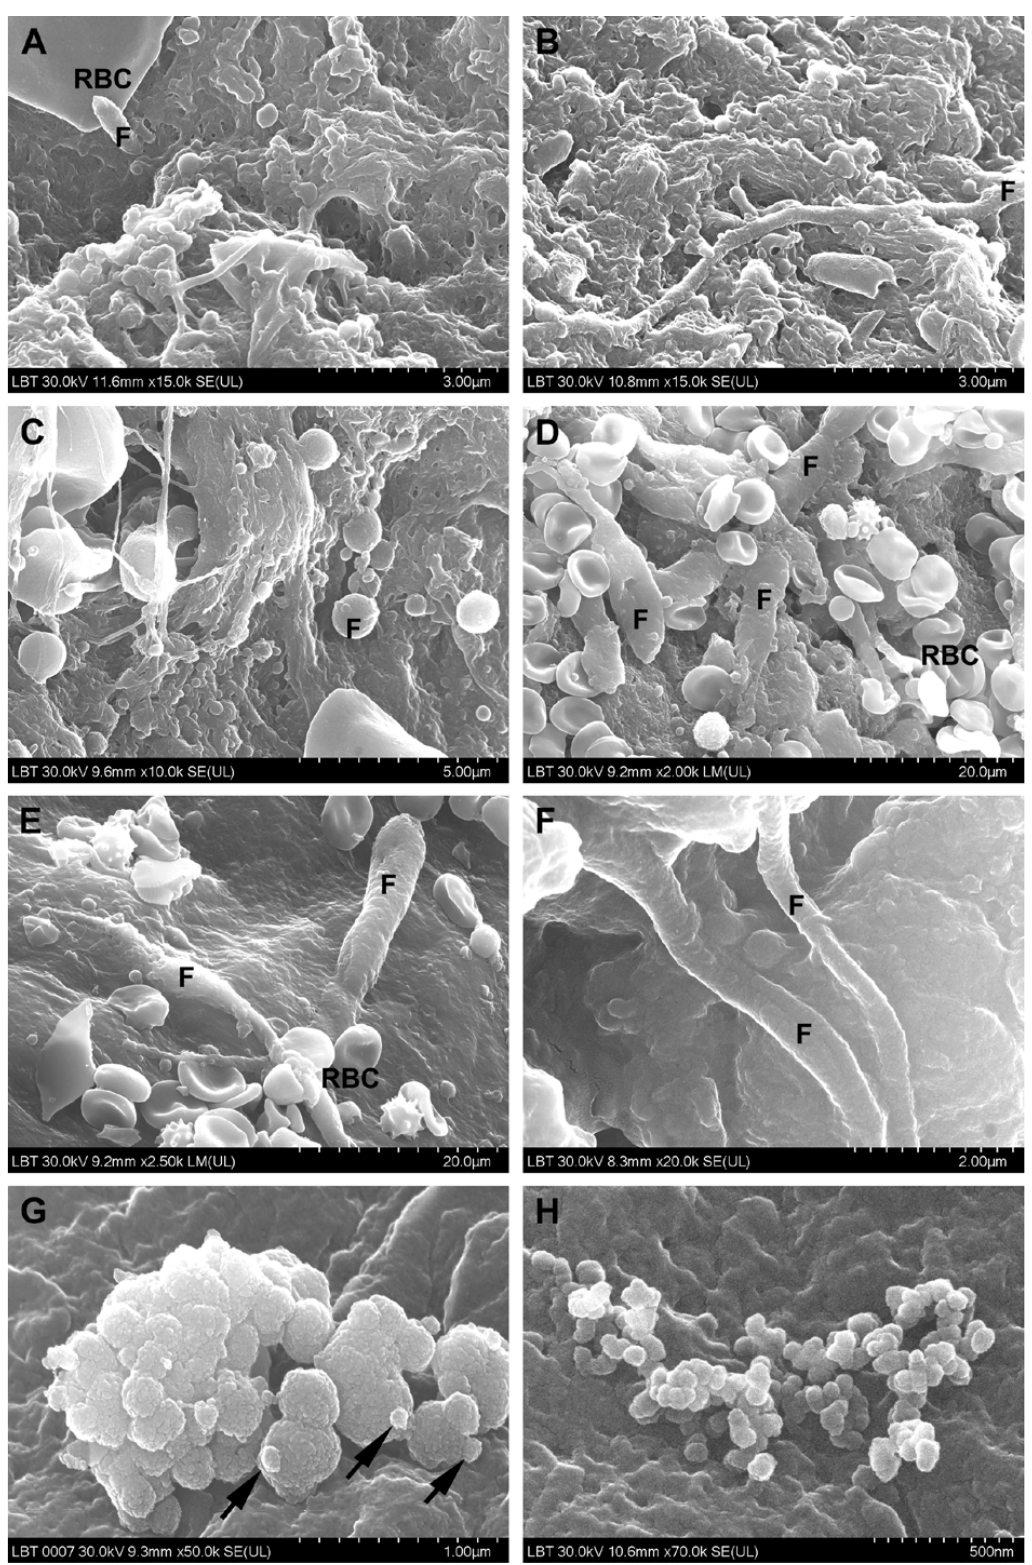
Figure 3. Surface of the nasal mucosa in CRSwNP samples (scanning electron microscopy): ( A – C )—mixed microbial biofilms (bacteria and fungi); ( D – G )—filamentous ( D – F ) and spherical fungal aggregates ( G ), the arrow indicates budding elements); ( H )—nanomicrobial aggregate (F—fungi, RBC—red blood